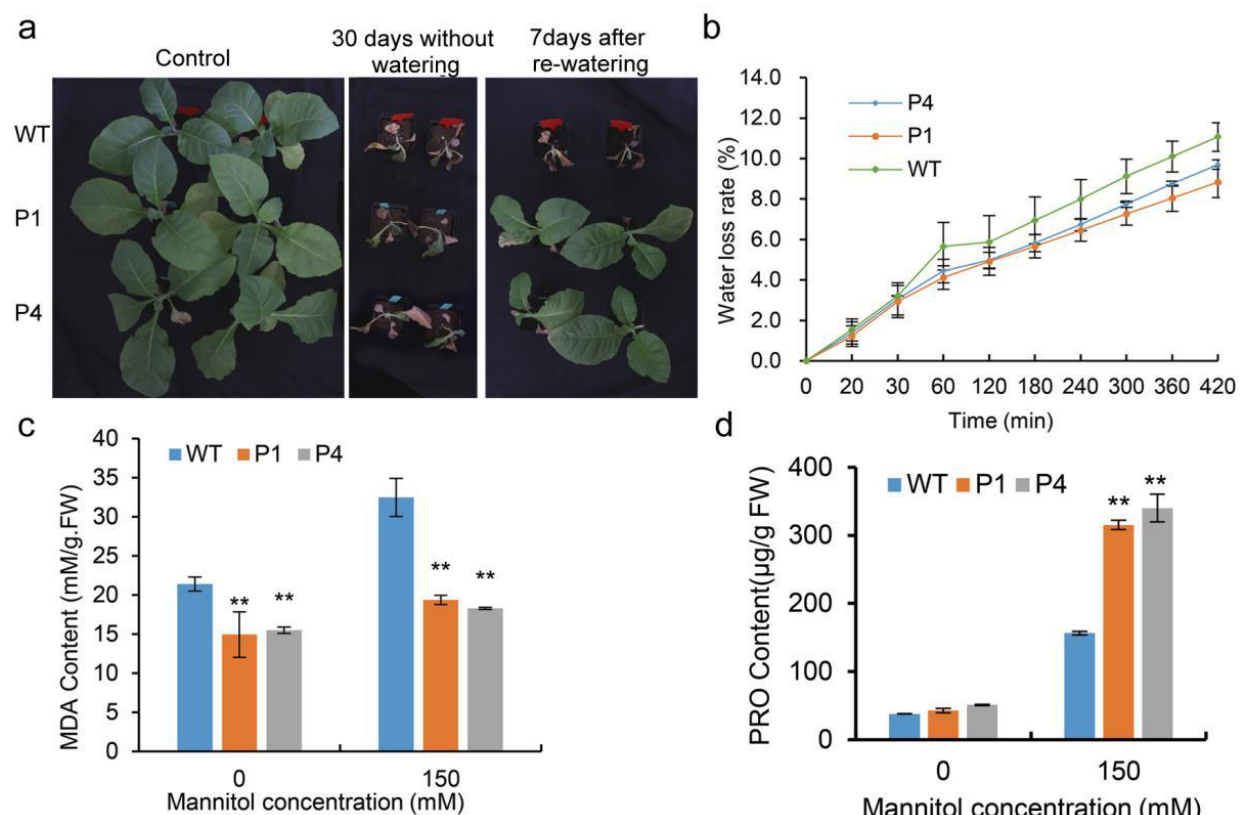
Figure 5. Drought resistance of wild-type (WT) and EuPIP1;2 -overexpressing tobacco. ( a ) The WT and EuPIP1;2 -overexpressing tobacco plants after drought stress treatment for 30 days and rewatering for 7 days. ( b ) Water loss from the leaves of WT and EuPIP1;2 -overexpressing tobacco in vitro. ( c ) Malondialdehyde (MDA) content in leaves of WT and EuPIP1;2 -overexpressing tobacco treated with 0 or 150 mM mannitol. ( d ) Proline content in leaves of WT and EuPIP1;2 -overexpressing tobacco treated with 0 or 150 mM mannitol. Data were analyzed statistically using SPSS. ** p < 0.01. The content of MDA reflects the degree of cell membrane damage in plants, and PRO content can be used as a biochemical indicator of plant resistance. To further study the effects of EuPIP1;2 overexpression on the physiology and biochemistry of transgenic tobacco, the MDA and PRO contents in leaves of transgenic and WT plants under man- nitol treatment were measured. Under the non-stress treatment, the MDA contents of P1 and P4 transgenic plants were significantly lower (by 69.77% and 72.34%, respectively) compared with that of the WT. Under drought stress treatment, the MDA content of WT plants increased significantly, attaining 32.47 mM/g · FW, an increase of 11.07 mM/g · FW; in contrast, the MDA contents of P1 and P4 plants were 19.36 mM/g FW and 18.26 mM/g ·